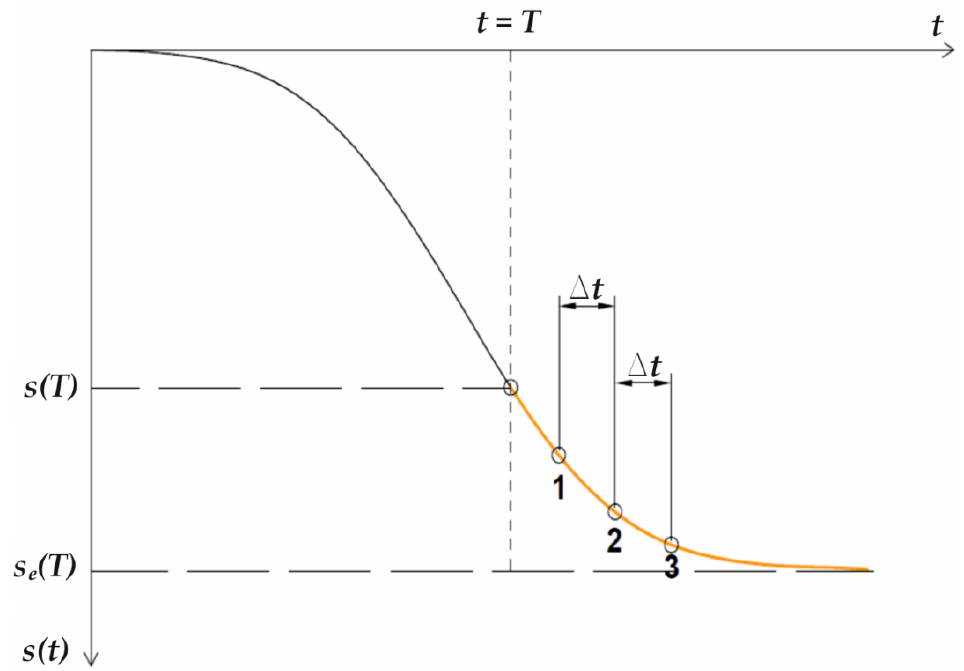
Figure 3. Subsidence calculation method for the three-point solution.